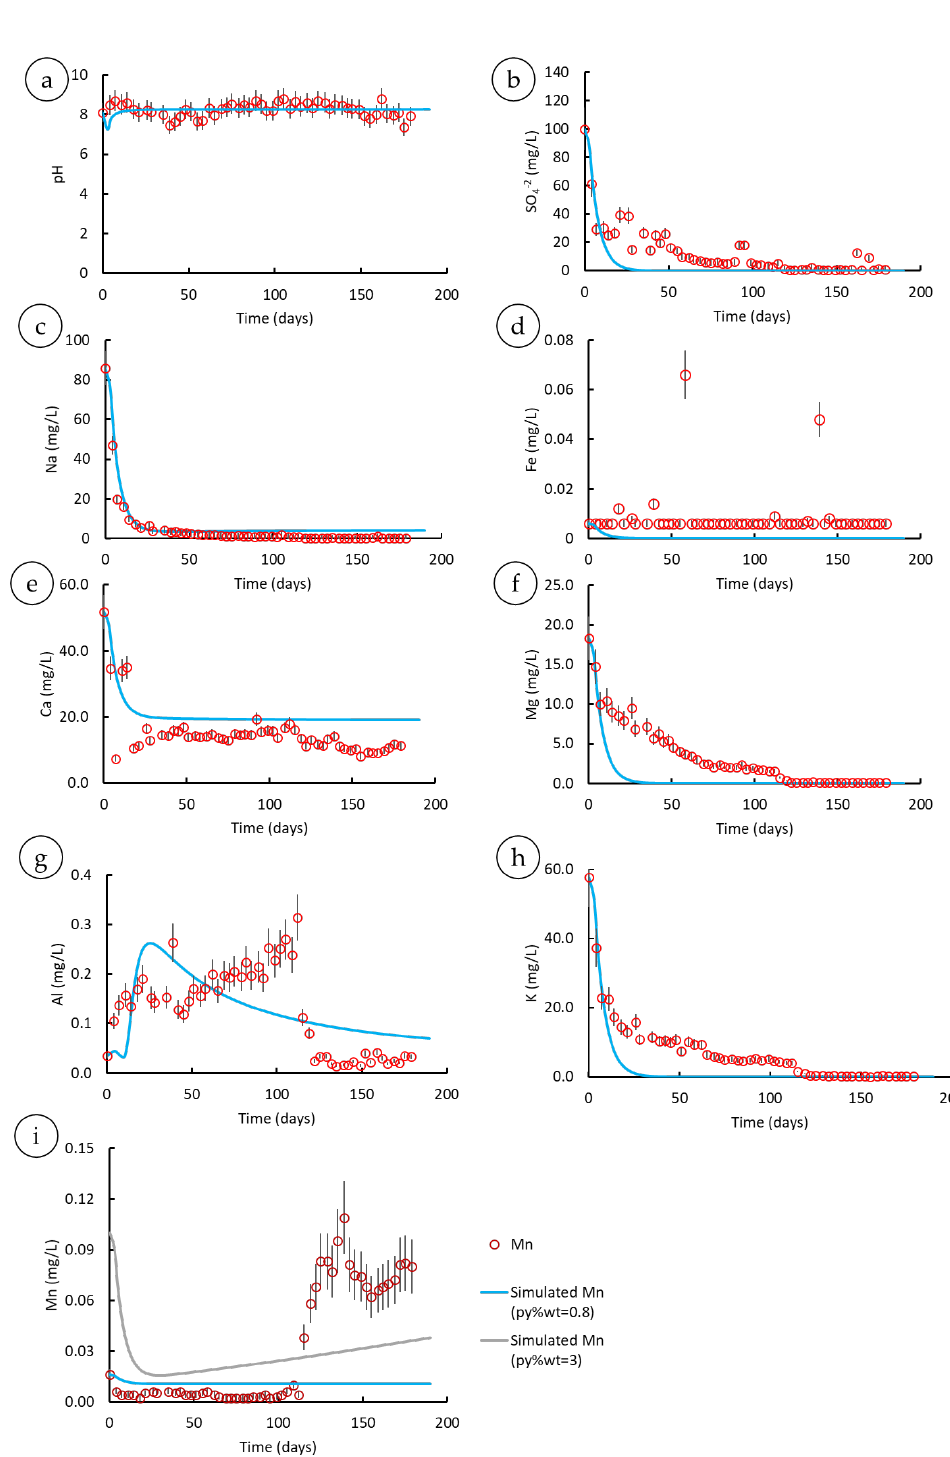
Figure 6. Weathering cells test D1 and PHREEQC modeling results. ( a ) Experimental and simulated results of the pH. ( b ) Experimental and simulated results of sulfate. ( c ) Experimental and simulated results of sodium. ( d ) Experimental and simulated results of the total dissolved iron. ( e ) Experi- mental and simulated results of total dissolved calcium. ( f ) Experimental and simulated results of total dissolved magnesium. ( g ) Experimental and simulated results of total dissolved aluminum. ( h ) Experimental and simulated results of total dissolved potassium. ( i ) Experimental and simulated results of total dissolved